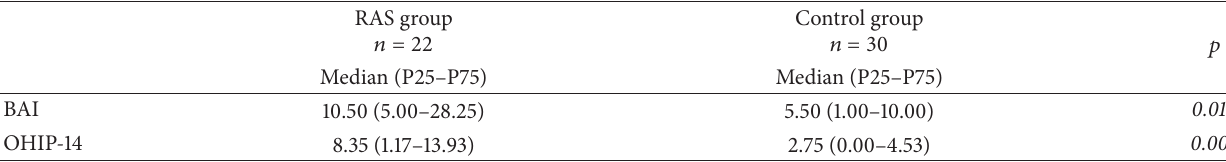
Table 2: Scores of the Beck Anxiety Inventory (BAI) and the Oral Health Impact Profile-14 (OHIP-14) in the RAS and control groups. RAS group 𝑛 = 22